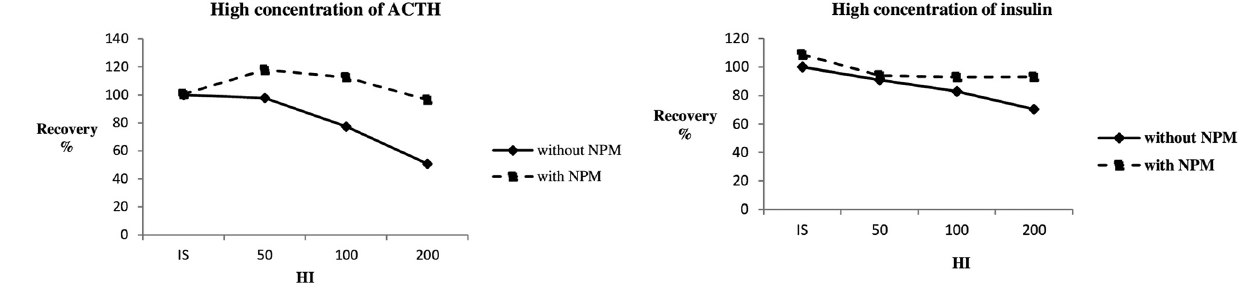
Figure 2: High concentration of ACTH recovery graphic between without NPM and with NPM groups. ACTH concentrations decreased to respectively 77 and 50% in the group without NPM. By adding NPM at the same degree of hemolysis (100 and 200 HI), the ACTH concentrations increased to 112 and 96%, respectively.